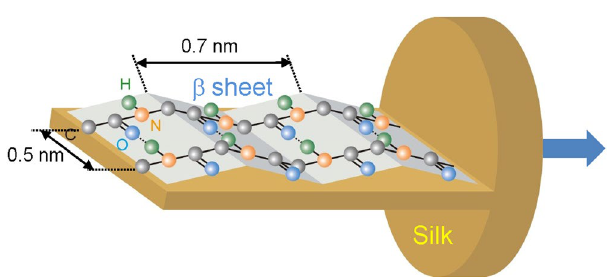
Figure 7. The orientation of the C = O, C-N, and N-H bonds in amide structure of the L-section of silk fiber 23,39 confirmed in this study by the hyper-spectral imaging (see, Fig. 4). Only the in-plane components of β -sheets are drawn without out-off-plane alkyl moieties; hydrogen bonding responsible for β -sheet crystallisation is shown by the dotted line O  H. An arrow marks fiber drawing (strain) direction important to alignment of β - sheets. Microtome slices allowed to measure absorbance of the lateral flat cross sections without introduction of a fiber shape related